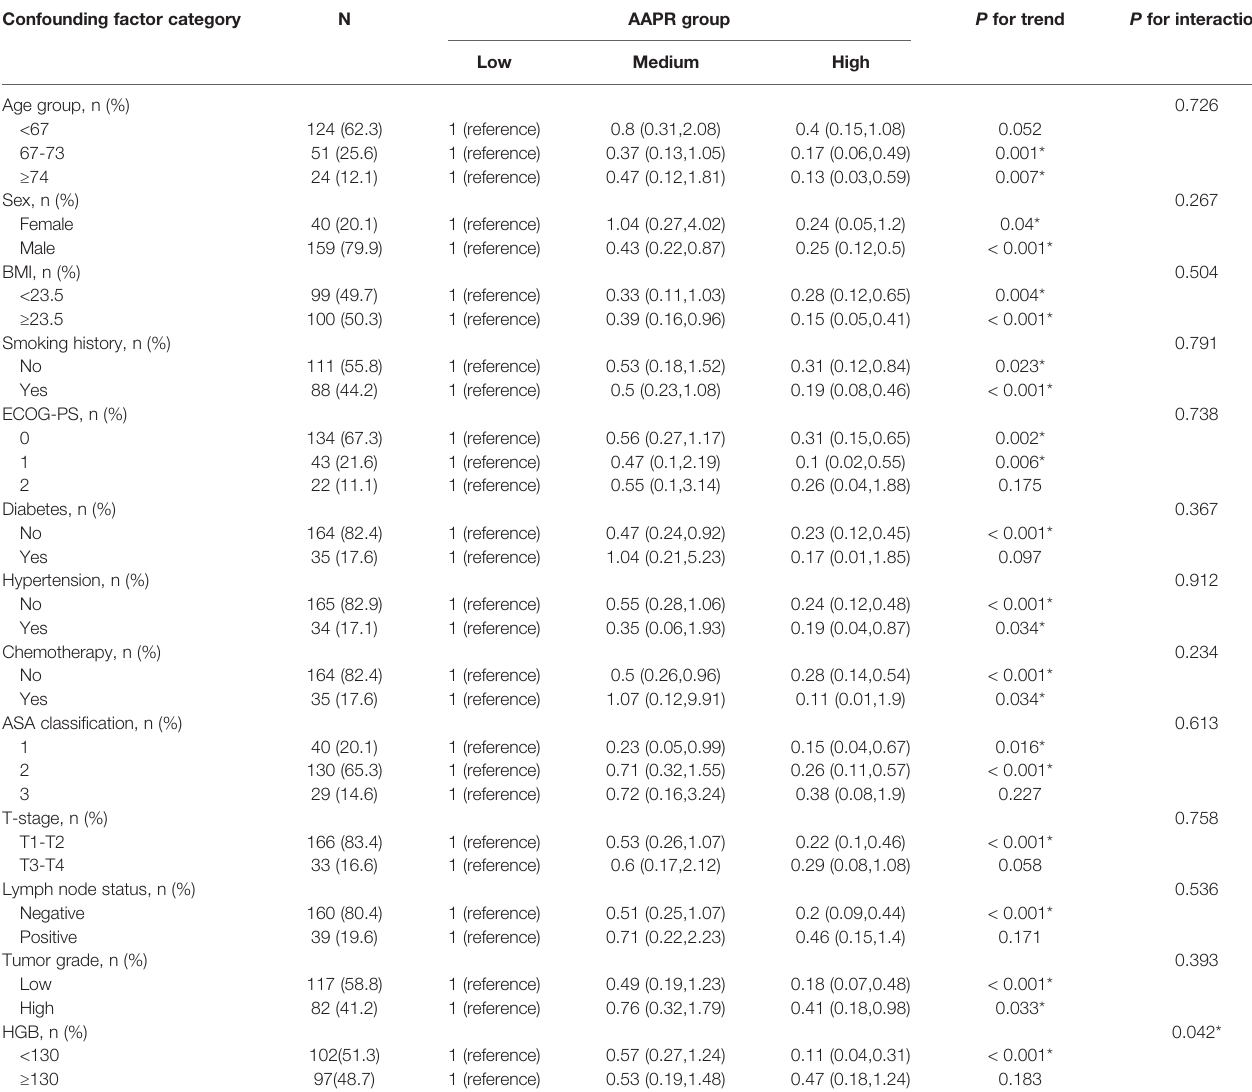
TABLE 4 | Subgroup analysis using potential confounders as the strati fi cation variables. Confounding factor